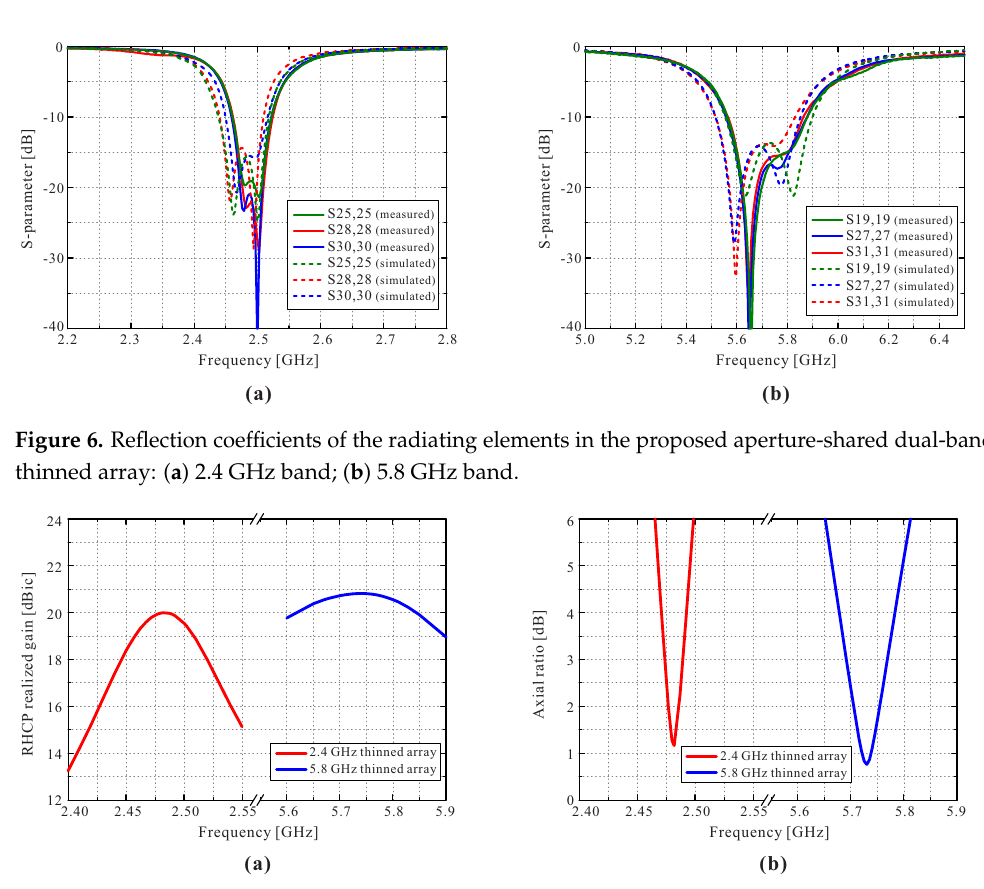
Figure 7. Simulated results of the proposed aperture-shared dual-band thinned array: ( a ) realized gain; ( b ) axial ratio.